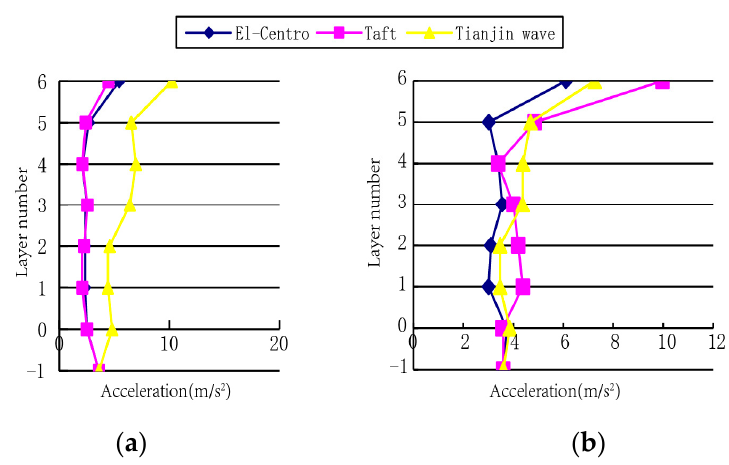
Figure 11. The peak acceleration (0.36 g). ( a ) Continuous control; ( b ) switch control.